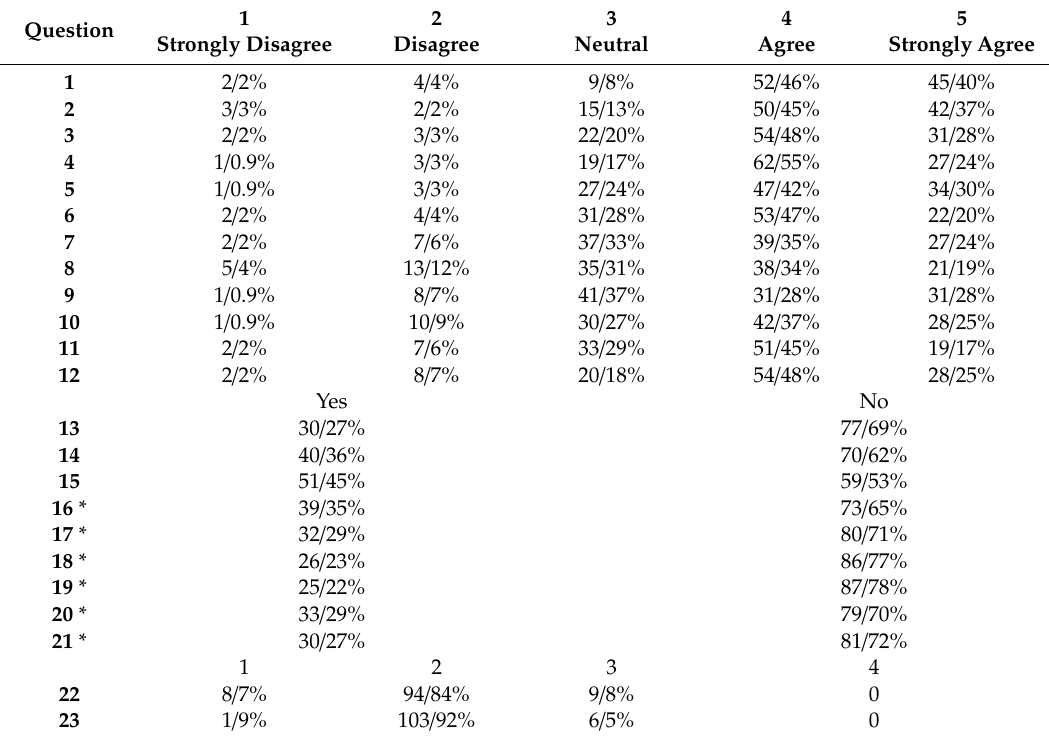
Table 3. Clinical Governance Awareness